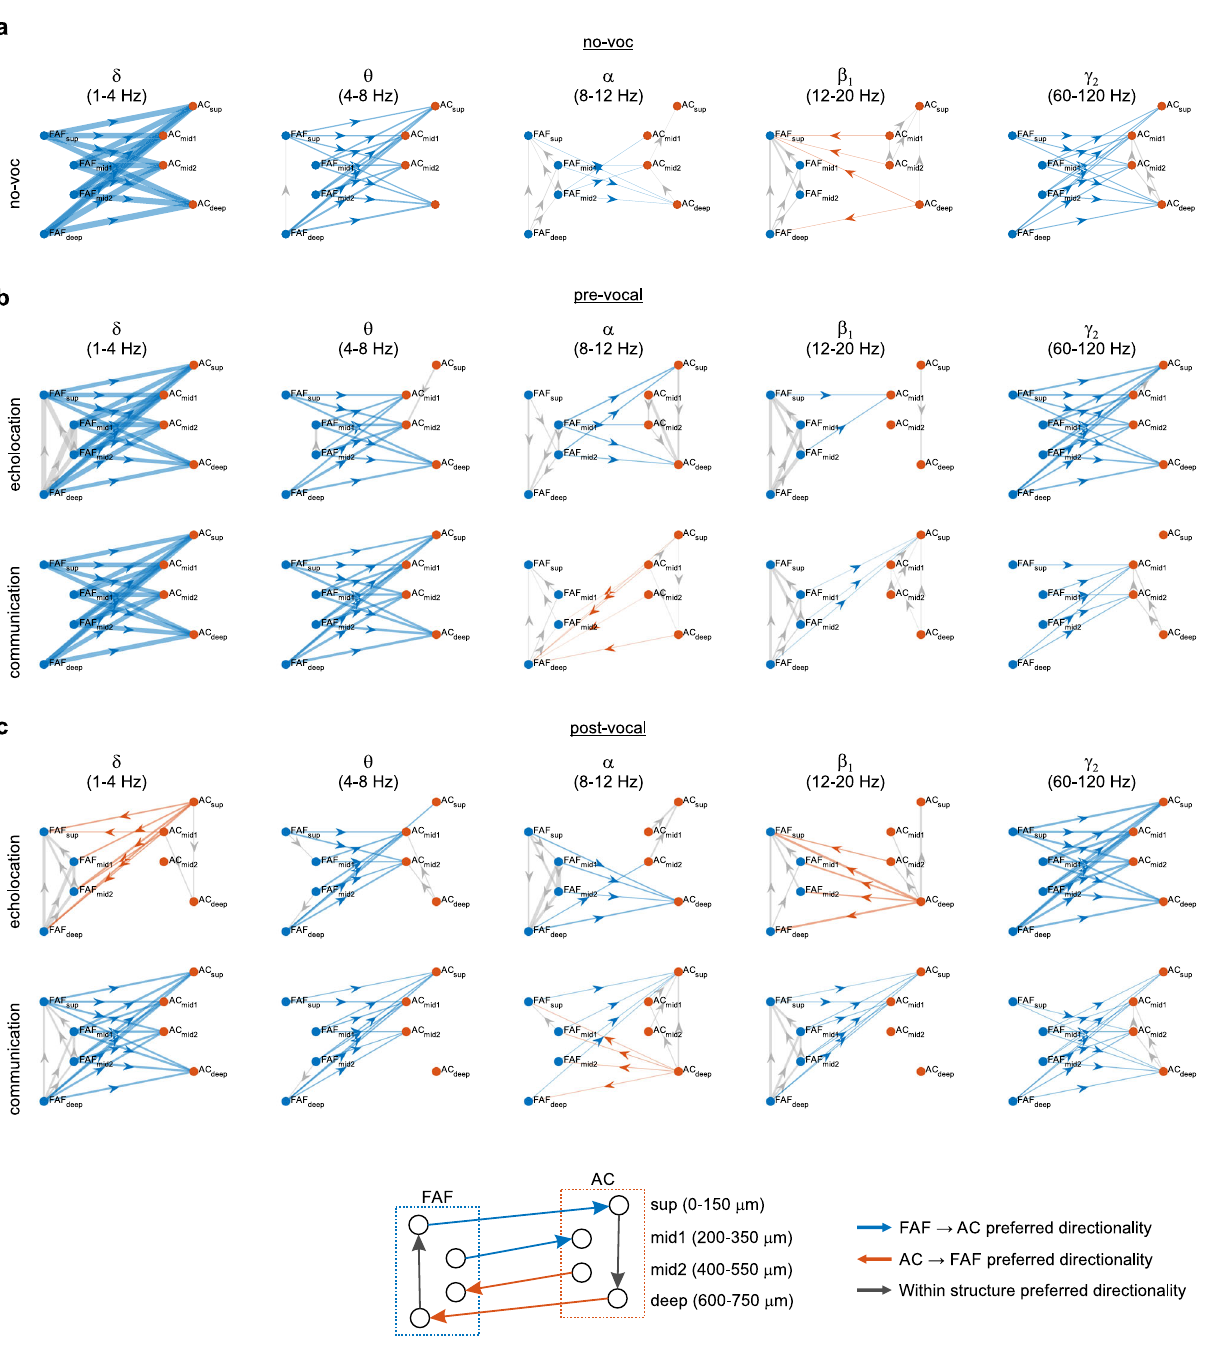
Fig. 2 Directed connectivity patterns in the FAF-AC network. a Graph visualization of directed connectivity between FAF and AC during no-voc periods. Channels in frontal and auditory cortices were combined into four categories: top (0 – 150 μ m), mid1 (200 – 350 μ m), mid2 (400 – 550 μ m), and bottom (600 – 750 μ m). Graph edges are weighted according to the strength of the preferred directionality (FAF → AC in blue; AC → FAF in orange; within-area directionality in gray). Edges are only shown if there was signi fi cant preferred directionality according to a threshold de fi ned by bootstrapping. b Similar to a , but directed connectivity was calculated in the pre-vocal echolocation and communication conditions. c Same as b , with connectivity patterns obtained for post-vocal echolocation and communication